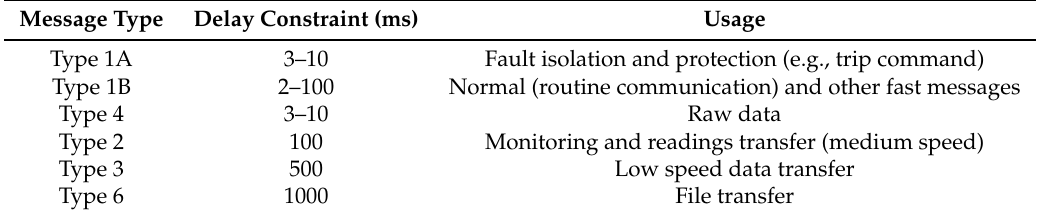
Table 1. IEC 61850-90-1 Delay Constraints